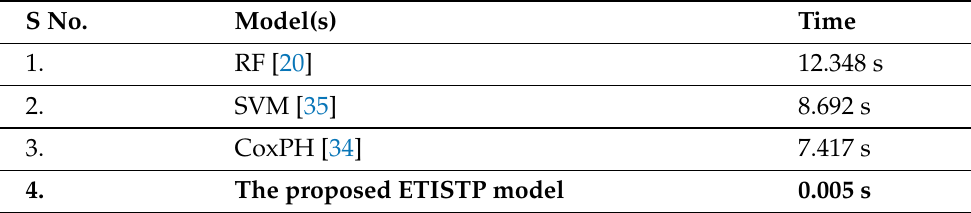
Table 14. Computational efficiency